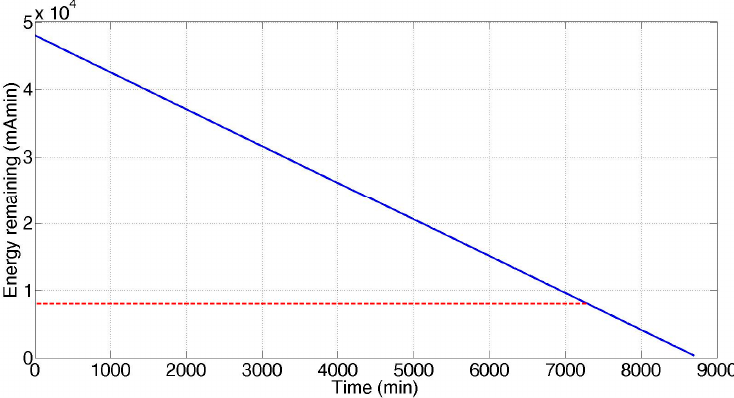
Figure 10. Lifetime estimation. Red line indicates the useful energy limit stored in the battery. Table 2. Sensor Nodes Comparison.